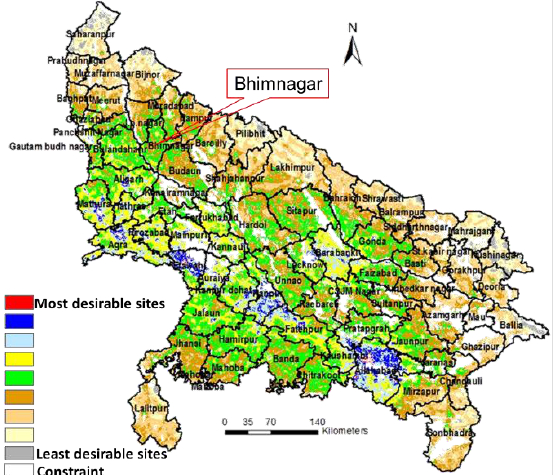
Figure 5. Site suitability for cold storages for the state of Uttar